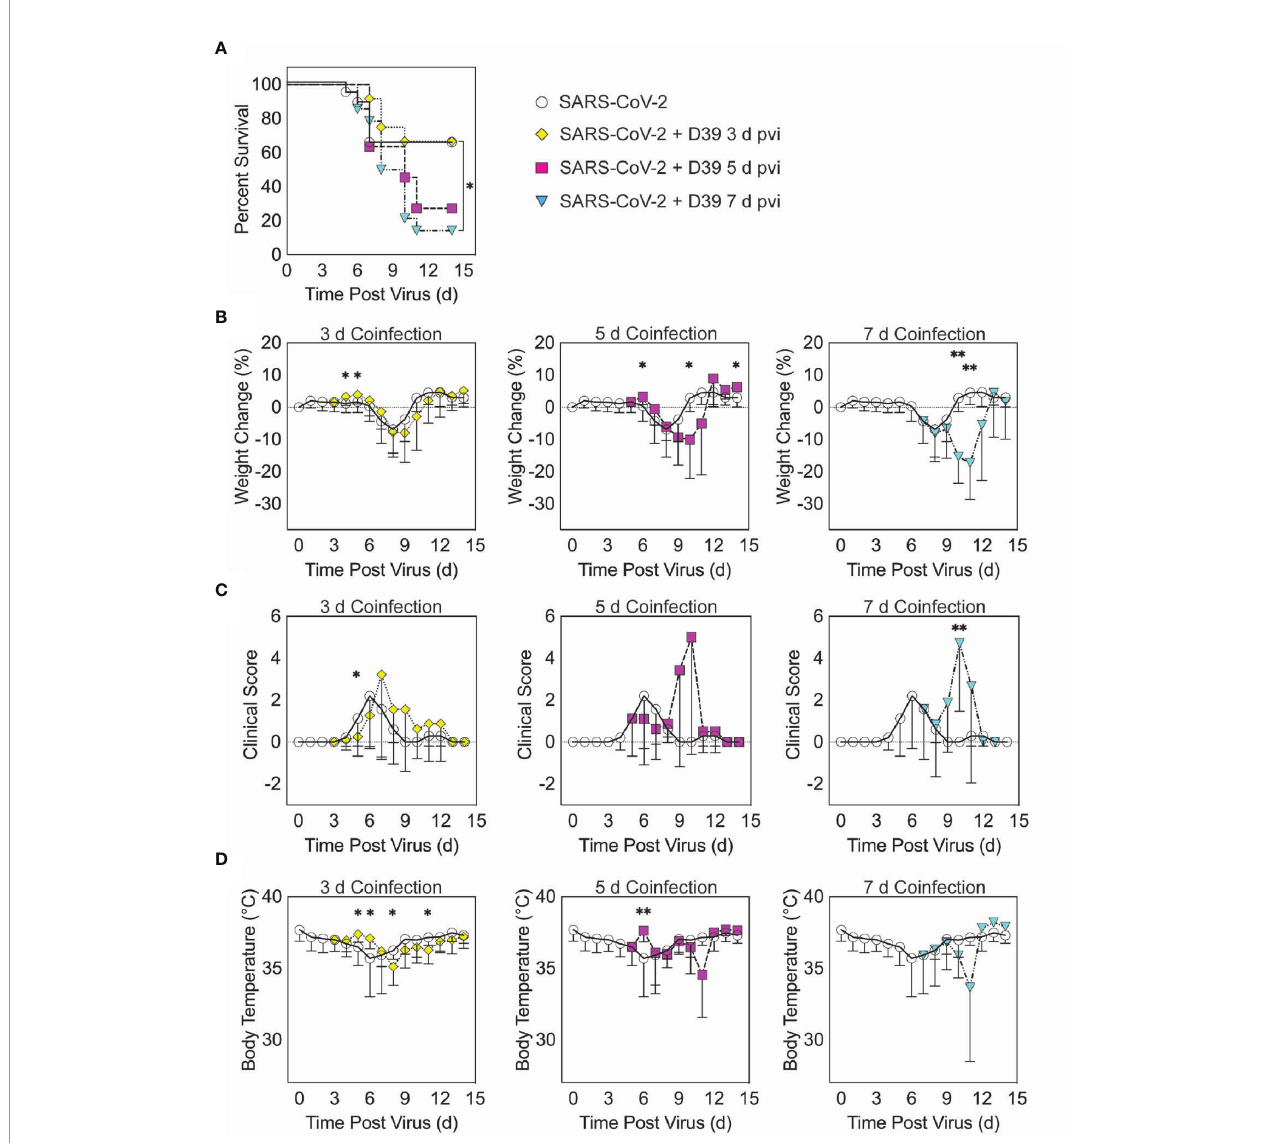
FIGURE 1 | SARS-CoV-2-pneumococcal coinfection in K18-hACE2 mice. Kaplan-Meier survival curves (A) , percent weight loss (B) , cumulative clinical score (C) , and temperature (D) of mice infected with SARS-CoV-2 (250 PFU; white circles, solid lines) followed by 10 3 CFU D39 at 3 d (yellow diamonds, dotted lines), 5 d (magenta squares, dashed lines), or 7 d (cyan triangles, dash-dotted lines) pvi. Data are shown as the mean ± standard deviation (SD) and signi fi cant differences are indicated by *, P < 0.05; **, P < 0.01 for comparisons between SARS-CoV-2 infection and SARS-CoV-2-pneumococcal